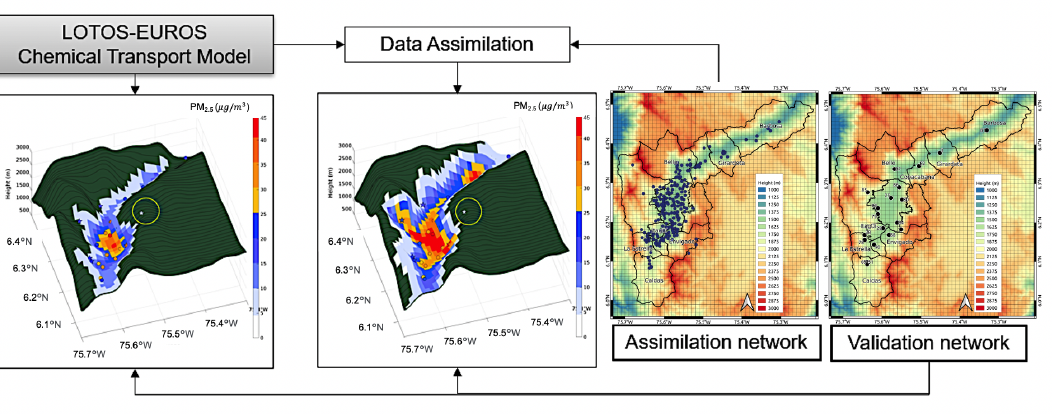
Figure 4. Data assimilation system with new measurements in the high part of the valley comple- menting the SIATA